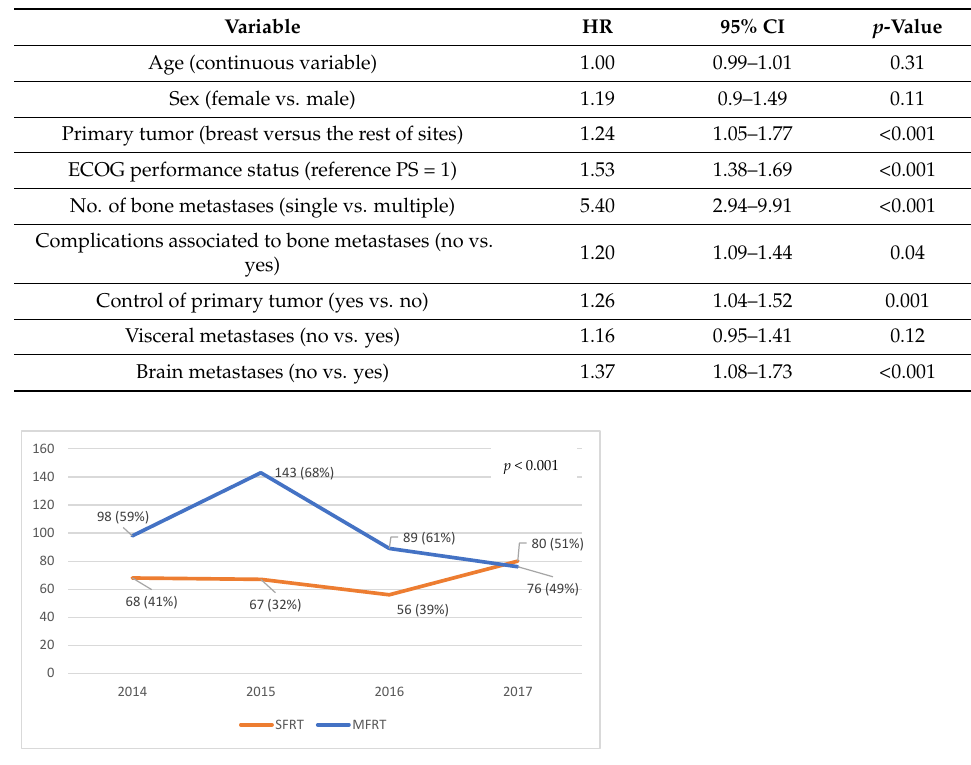
Figure 4. Radiotherapy regimens prescribed each year, in the period 2014 – 2017.